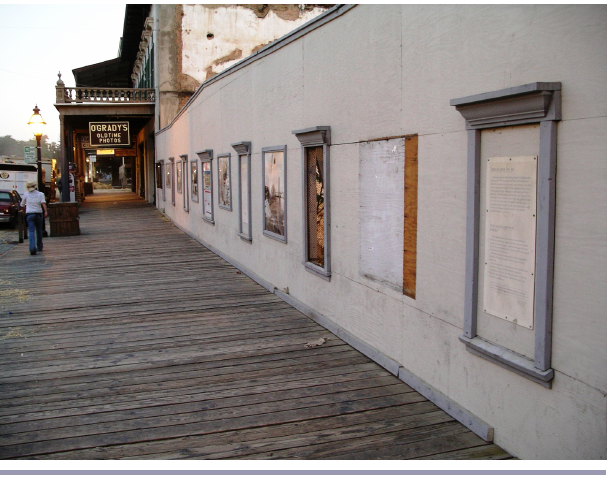
Fig. 4 . Public historical ecological education in the City of Sacramento Historic Landmark District, near the riverfront (photo by author).